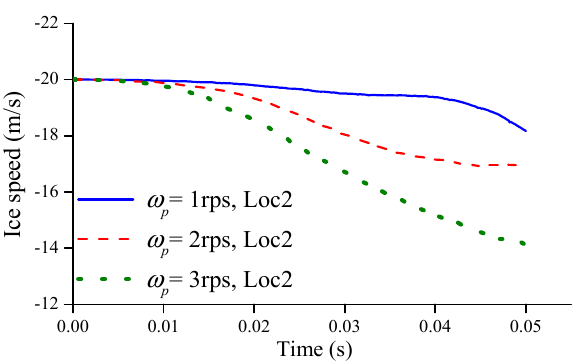
Figure 26. Time series of ice speed in the x direction based on simulations with different rotation speeds for collision location at Loc2.